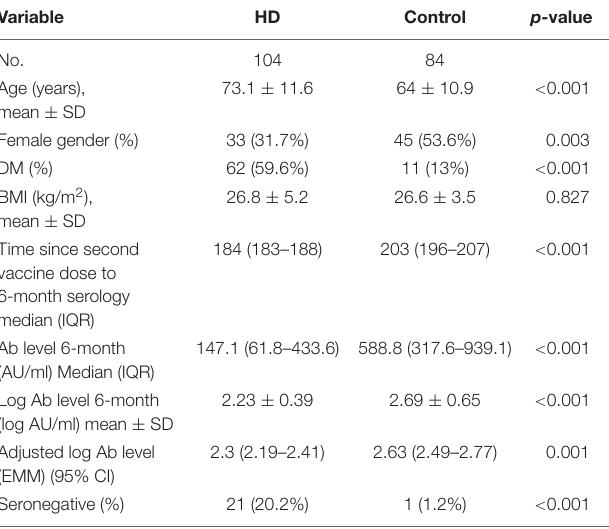
TABLE 1 | Baseline characteristics and antibody response.